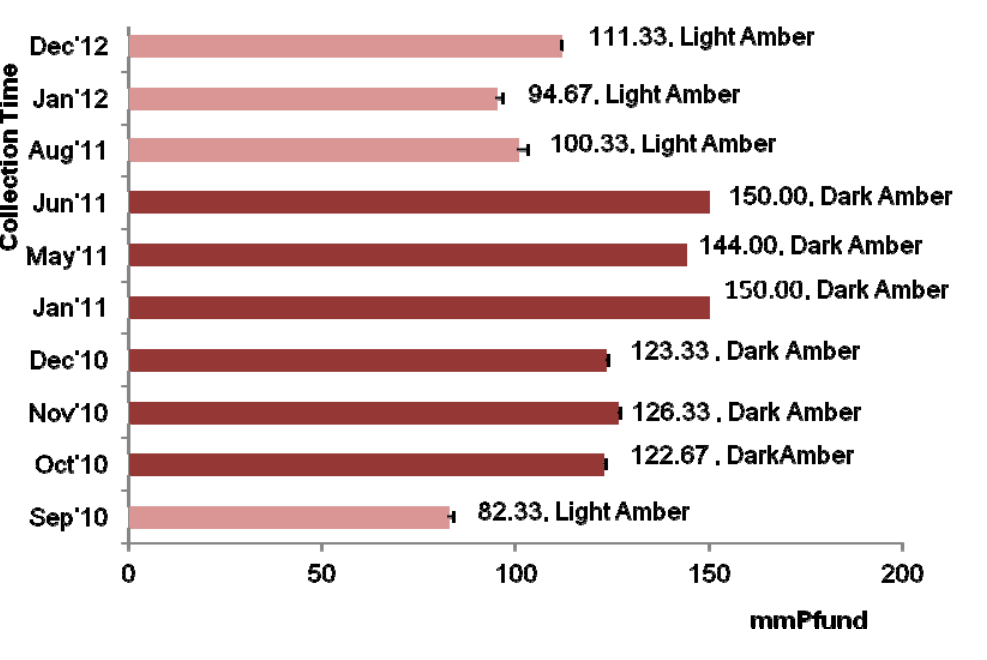
Figure 2. Color characteristics of the Malaysian acacia